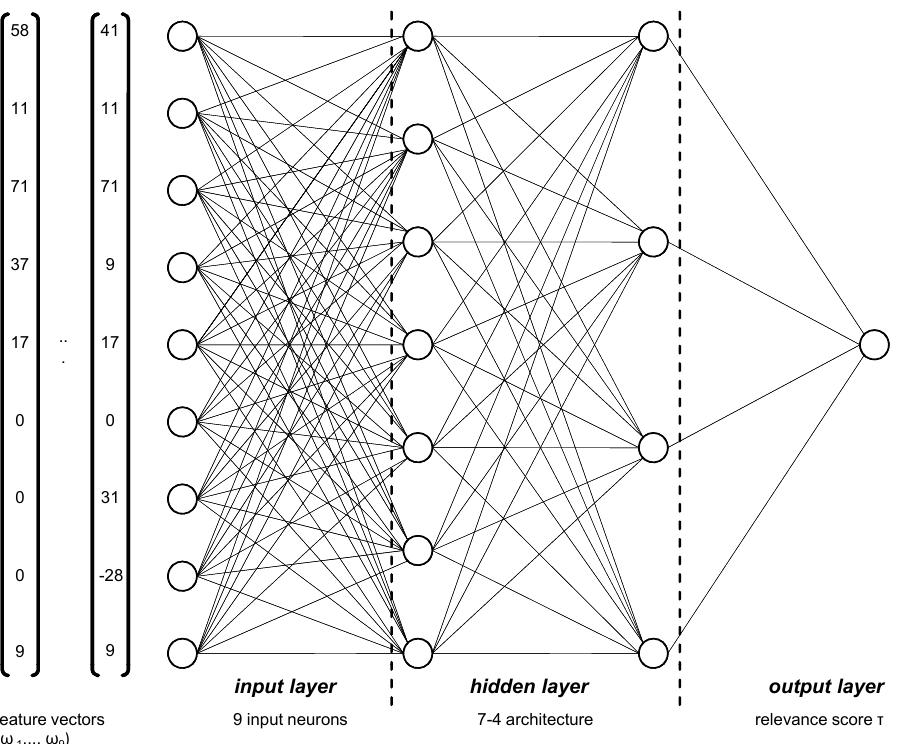
Figure 3: neural network for relevance ranking – the used neural network predict for a vector ~ω of 9 feature values the relevance of the database